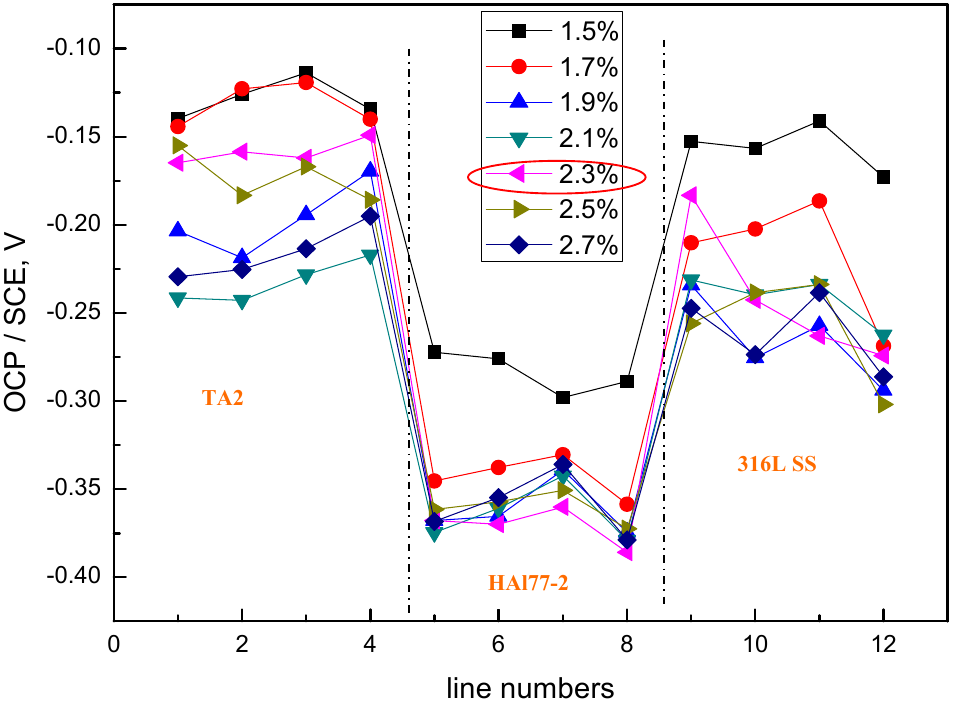
Figure 12. Average OCP distributions of each microelectrode line for CMEA3 after immersion in artificial seawater with different concentrations of chloride ions (wt %).